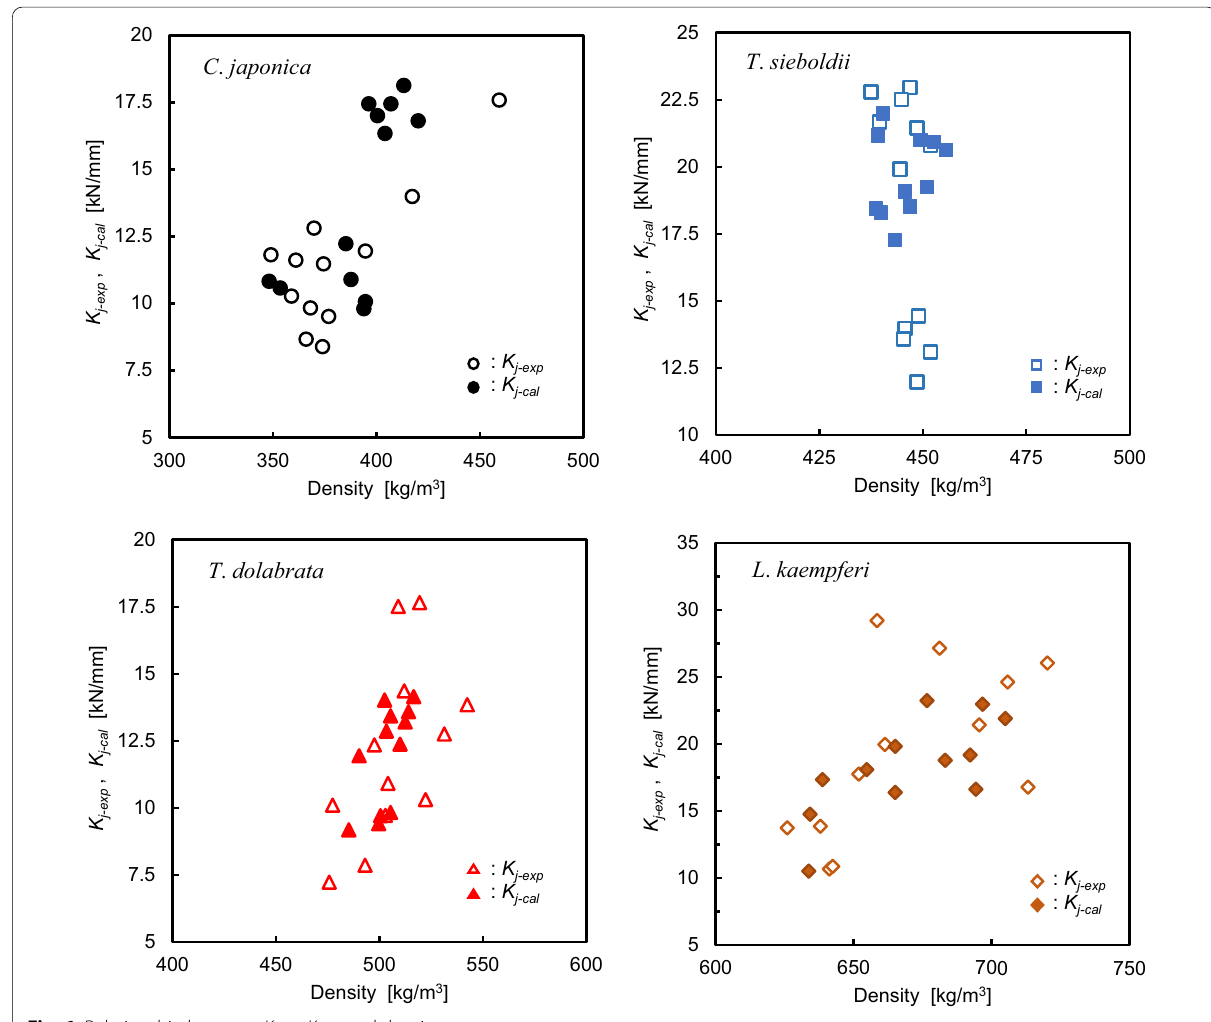
Fig. 6 Relationship between K j-exp , K j-cal , and